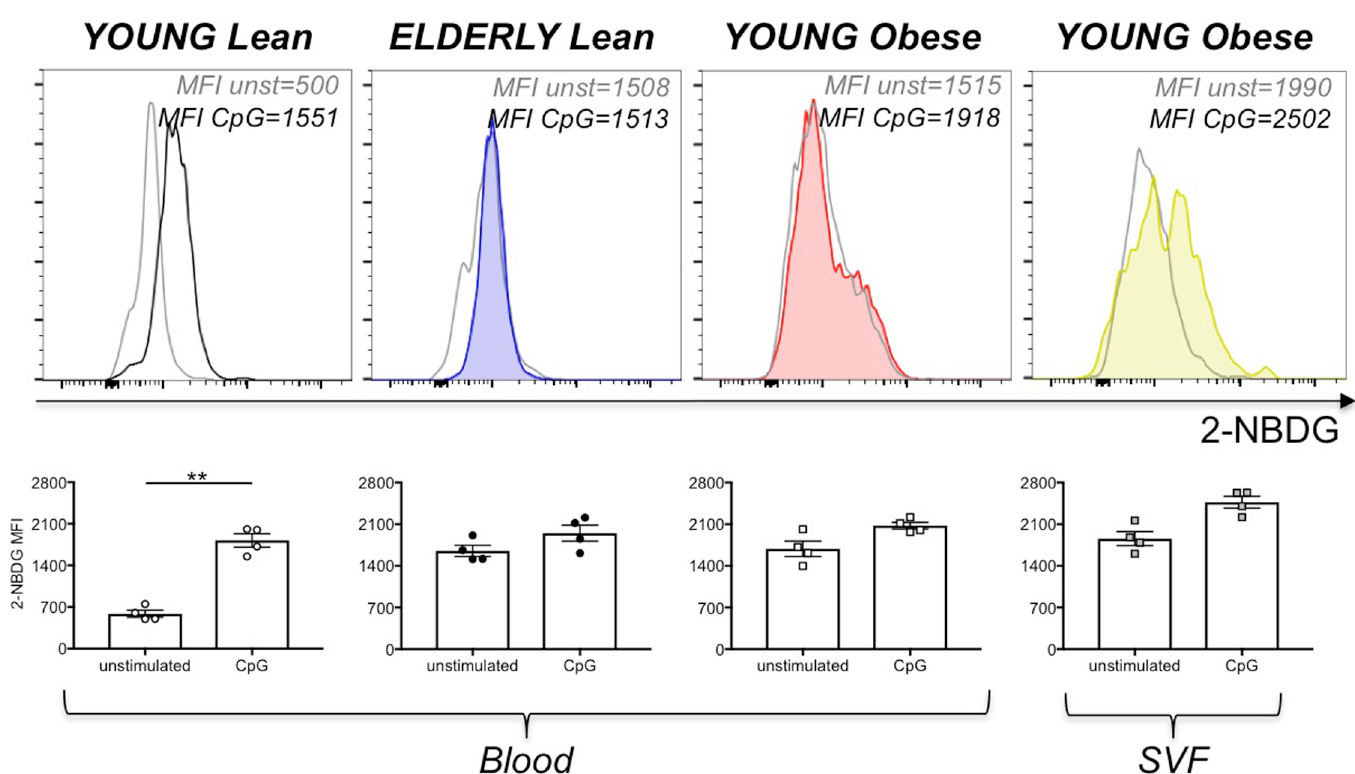
Fig 6. Effects of aging and obesity on glucose uptake in DN B cells. PBMC from the blood from young and elderly lean individuals and from the blood of young obese individuals were stained to evaluate the frequencies of DN B cells. The SVF from the SAT of young obese individuals was also stained. Young individuals giving PBMC and the SAT were age-, gender- and BMI-matched. Cells were incubated in the presence of 2-NBDG. Top . Representative histograms of 2-NBDG uptake are shown for each group of individuals. Bottom . Mean Fluorescence Intensity (MFI) ± SE of 2-NBDG uptake before and after CpG stimulation. Mean comparisons between groups were performed by Student’s t test (two-tailed). �� p <